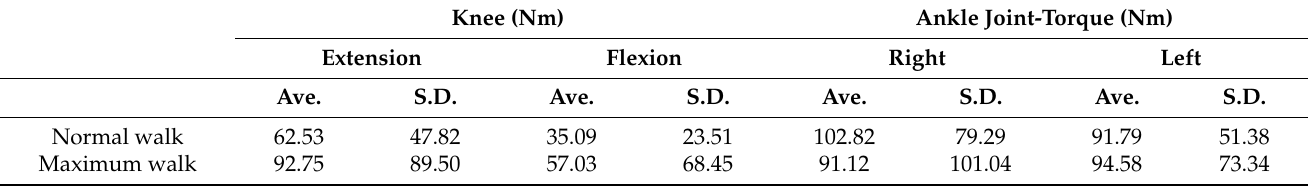
Table 10. Comparison of muscle factor during the normal walking and maximum walking of ordinary individuals. Knee (Nm) Ankle Joint-Torque (Nm) Extension Flexion Right Left Ave. Normal walk Maximum